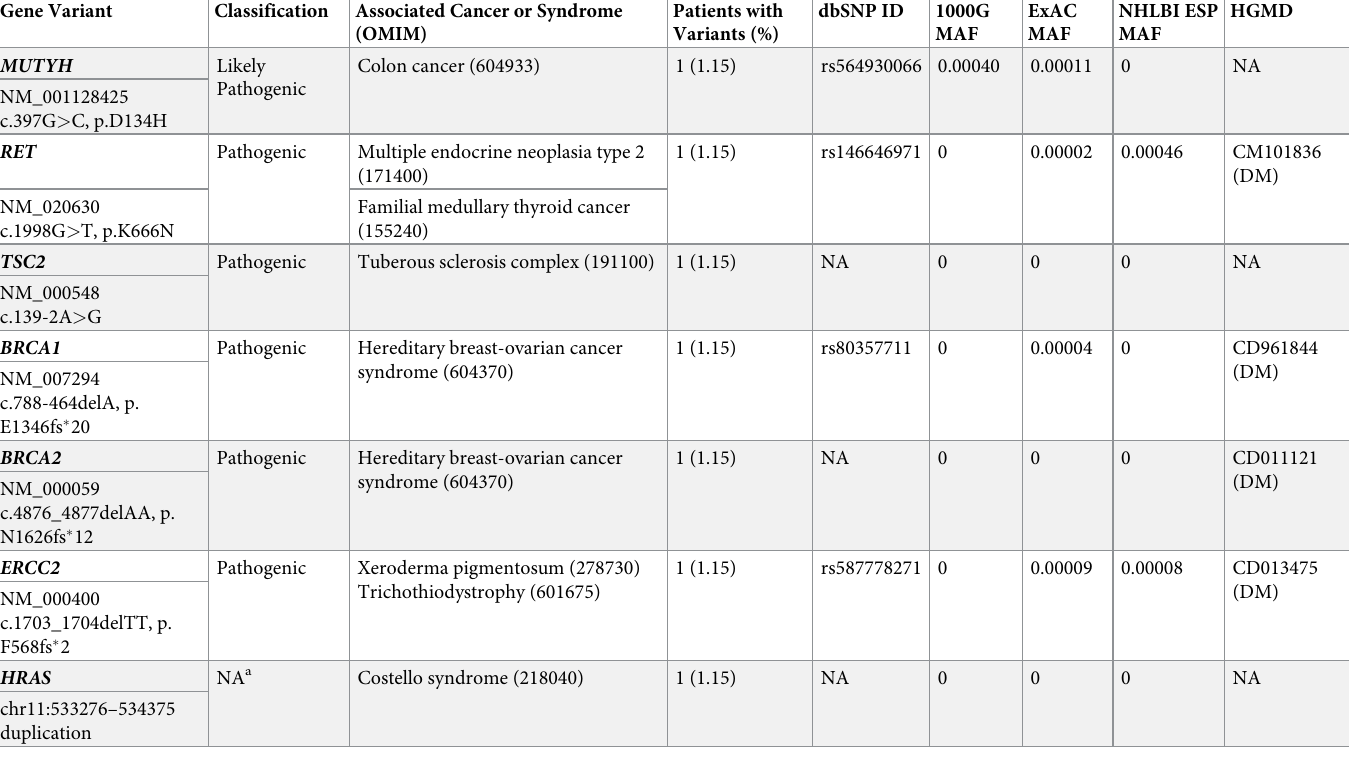
Table 2. Germline variants and copy number variation (CNVs) identified and associated